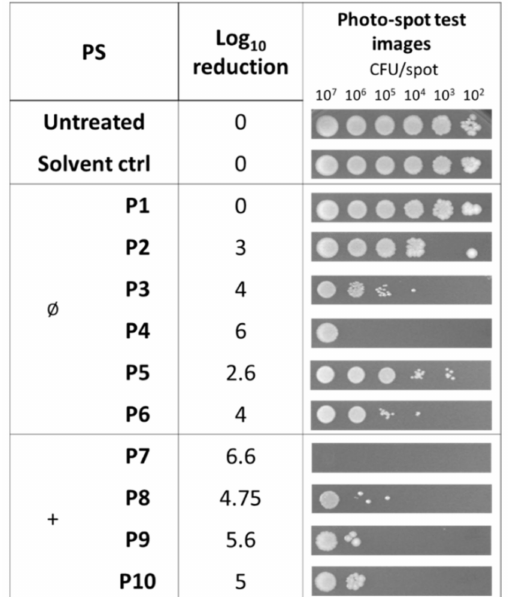
Figure 3. Photodynamic activity of diaryl-porphyrins on S. aureus ATCC 6538P evaluated by the photo-spot test. The neutral (Ø) and monocationic (+) porphyrins were administered at a final concentration of 10 µ M. “Untreated” lane corresponds to irradiated cells without PSs or DMSO. “Solvent control” corresponds to cells irradiated in the presence of DMSO. After 1 h of dark incubation and irradiation under 410 nm light (20 J/cm 2 ), the cells were incubated at 37 ◦ C O/N. Growth spots were checked and representative images are reported in the last column. Log 10 reduction values represent the mean of at least three independent